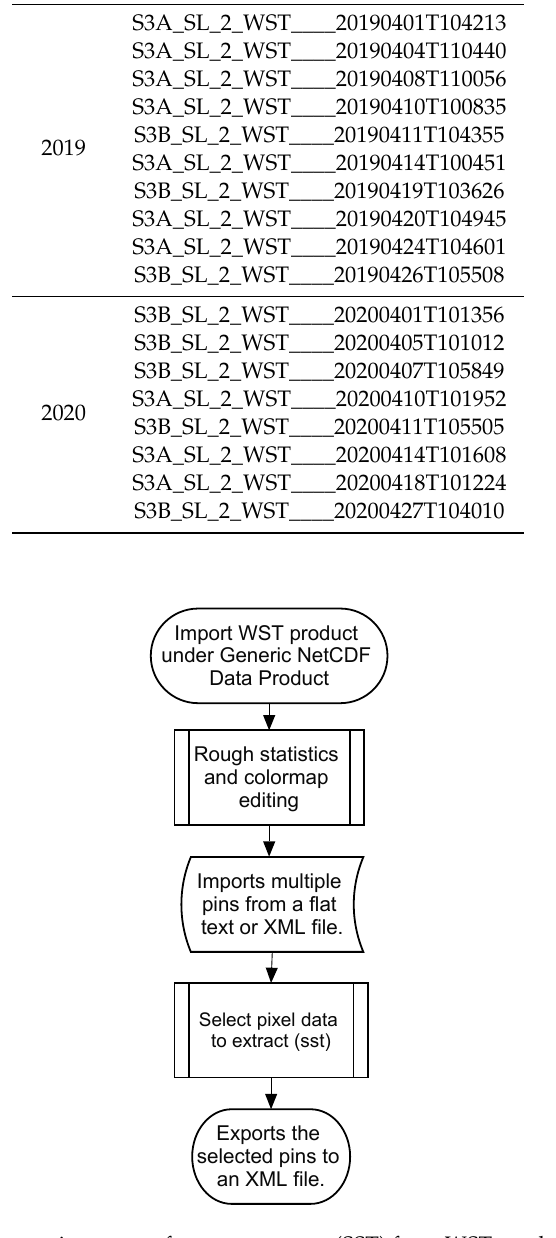
Figure 4. Workflow of extracting sea surface temperature (SST) from WST products in SNAP (Sentinel Application Platform) software.